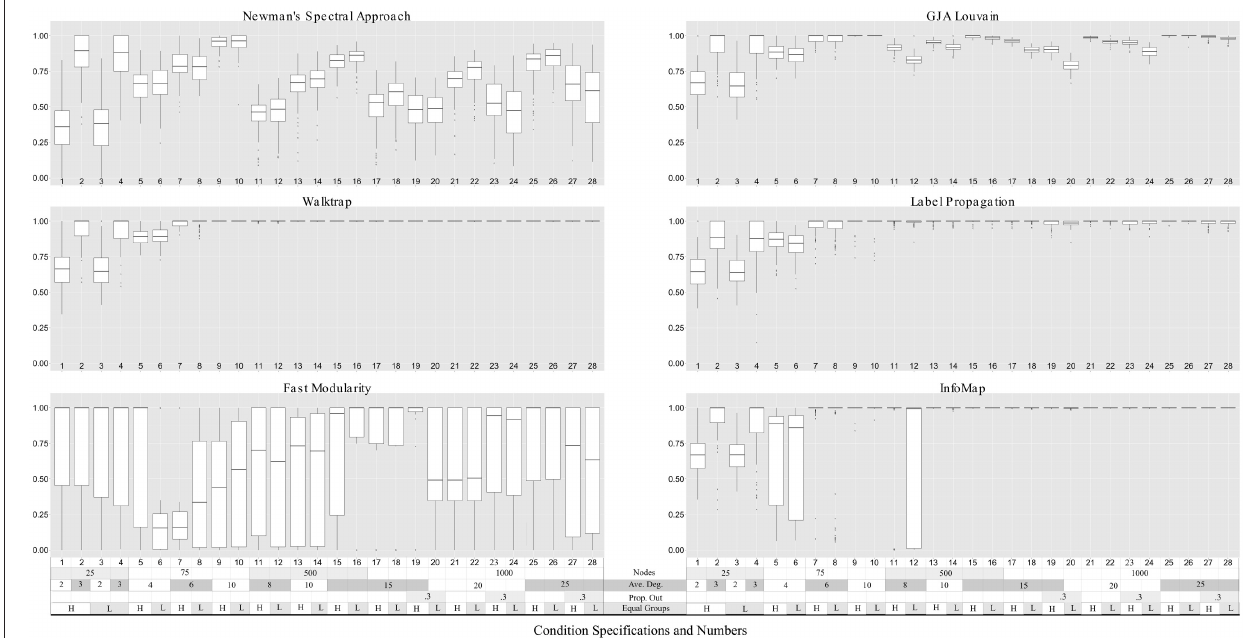
FIGURE 3 | Community precision for LFR count matrices. Simulation numbers correspond to those described in Table 2 . In the legend depicting the simulation parameters appended at the bottom of the graph, “Ave.” indicates average, “Prop. Out” indicates the proportion of edges that connect nodes with other nodes outside their community (“mixing parameter,” “L,” and “H” indicates low and high number of equally-sized groups (“community distribution exponent”), respectively. No approach could reliably return community structures in count matrices with nodes = 25. Walktrap and Label Propagation consistently performed nearly perfectly for count matrices with nodes = 500 and